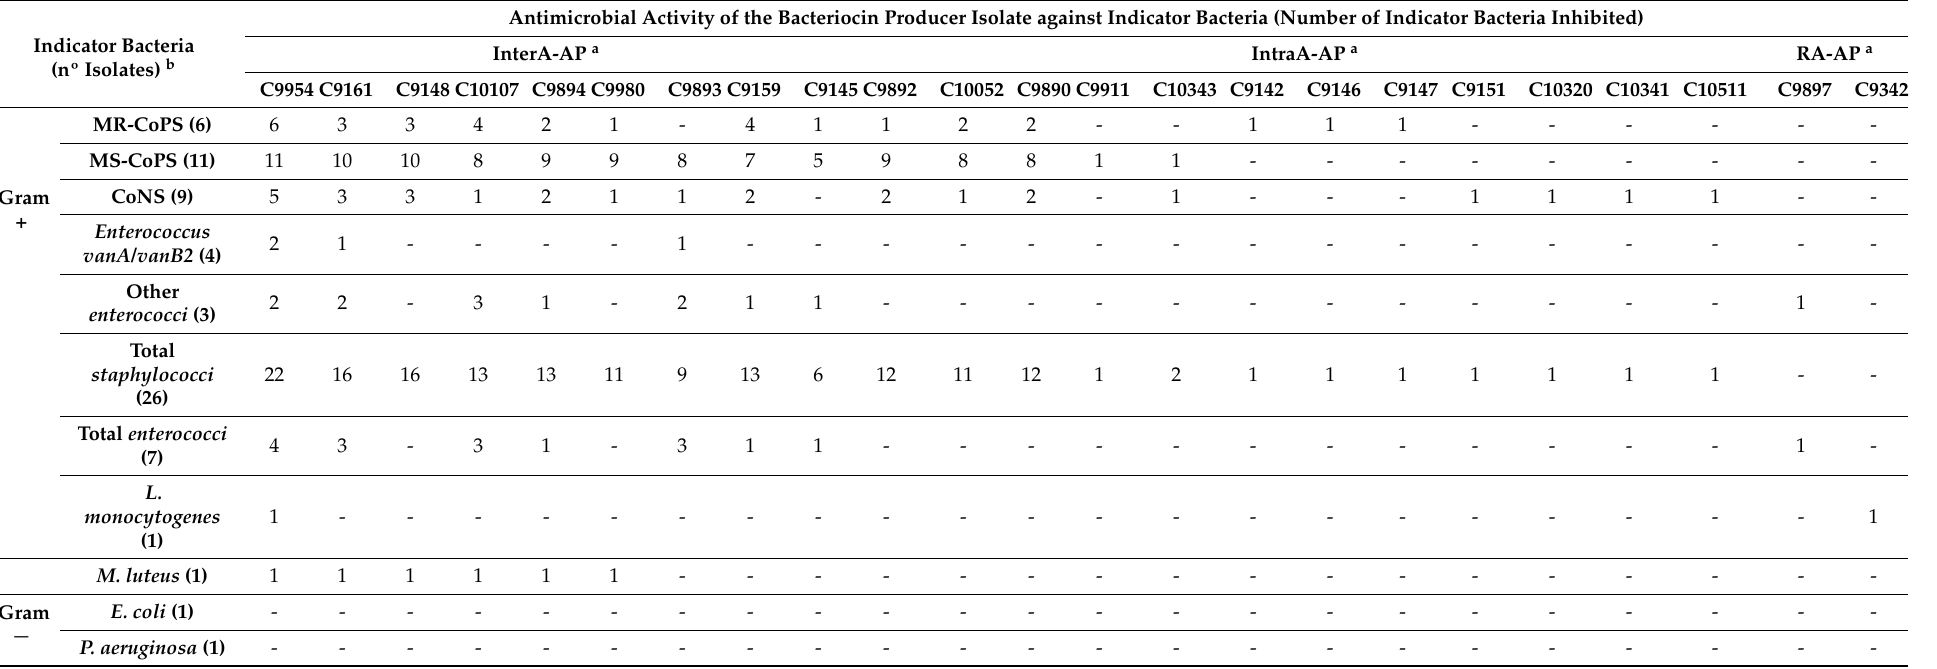
Table 3. Antimicrobial activity of the 23 S. lugdunensis isolates characterized as bacteriocin producers against the 37 indicator